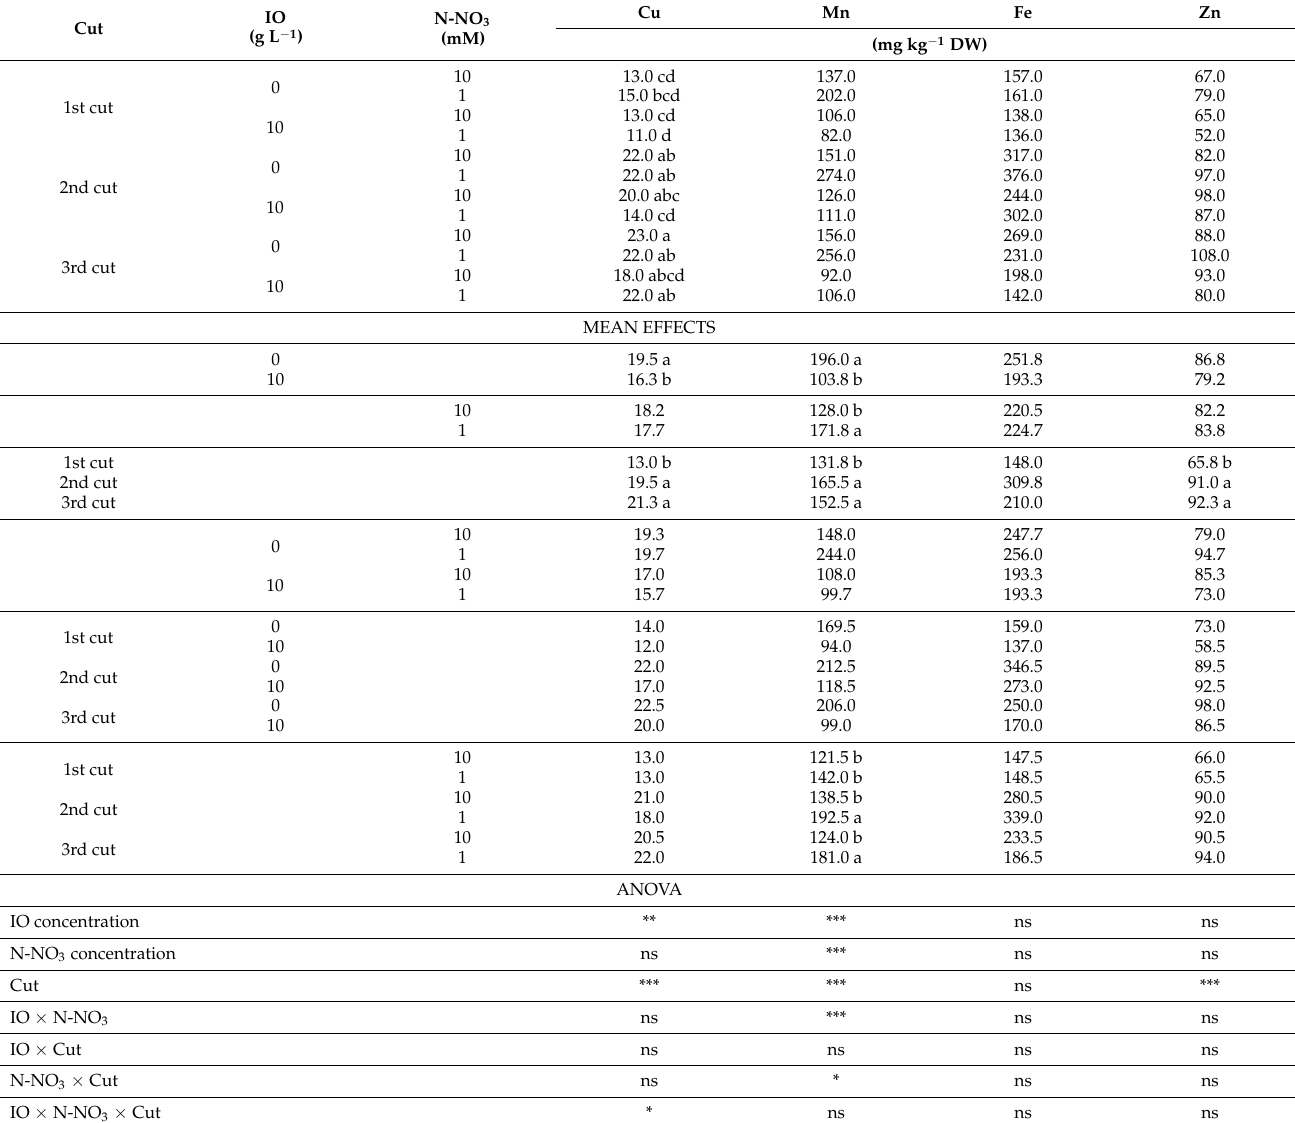
Table 7. Leaf concentration of copper (Cu); manganese (Mn); iron (Fe); and zinc (Zn) in Swiss chard plants grown hydroponically with different concentrations of the sea salt Instant Ocean (IO; 0 and 10 g L − 1 ) and nitrogen (1 and 10 N-NO 3 mM) in the nutrient solution. The leaves were harvested trice during the experiment (see Table 1 for more detailed information in the